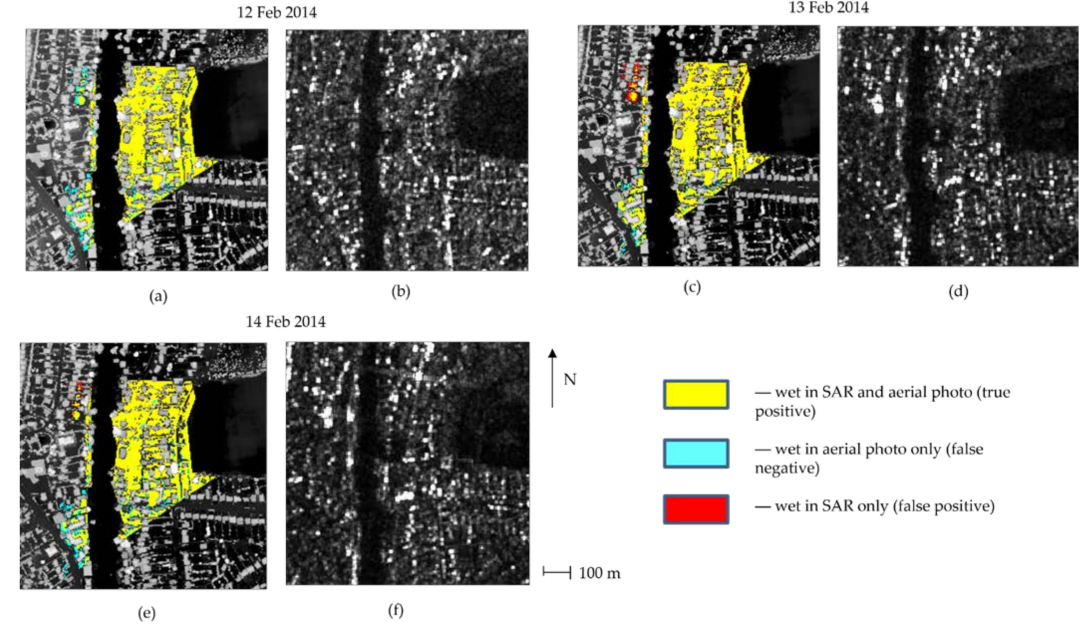
Figure 5. ( a ) Correspondence between the SAR image of 12 February 2014 and aerial photograph flood extents in urban area of Wraysbury, superimposed on the LiDAR image (lighter grey = higher), and ( b ) extract from SAR image of 12 February 2014; ( c , d ) as ( a , b ) for SAR image of 13 February 2014; and ( e , f ) as ( a , b ) for SAR image of 14 February